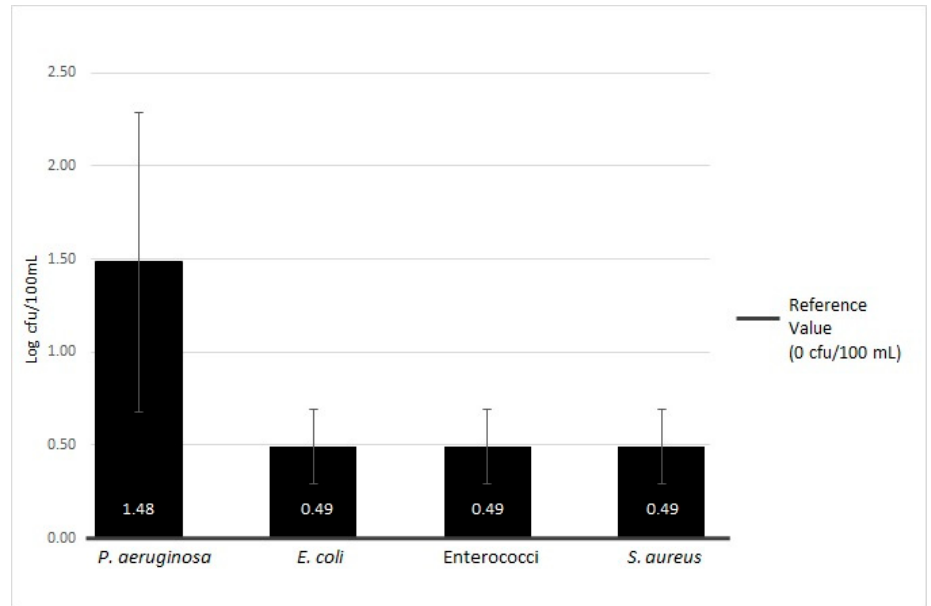
Figure 3. Microbiological contamination of total of samples of MWDs: Enterococci, Pseudomonas aeruginosa , Escherichia coli , and Staphylococcus aureus.